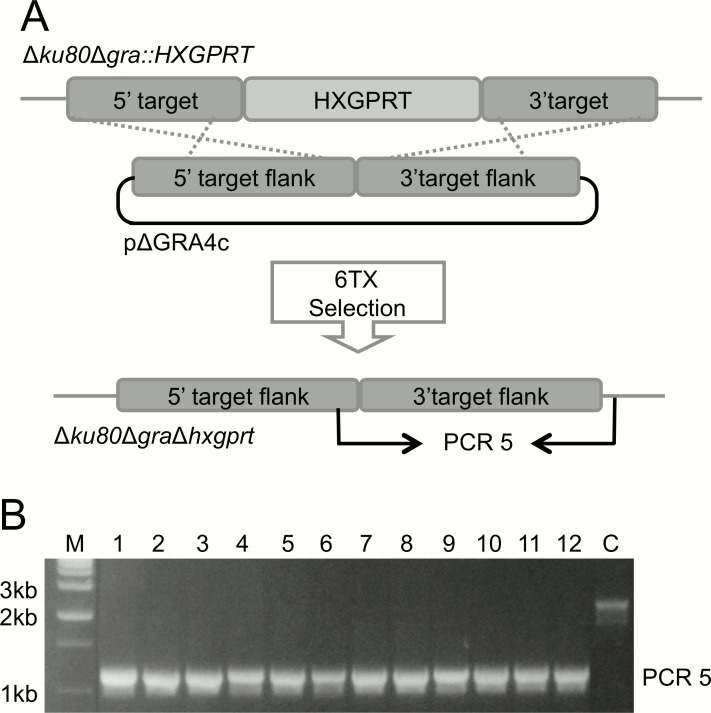
Strategy for removal of the HXGPRT selectable marker from a GRA gene locus.A) Removal of the HXGPRT selectable marker from RHΔku80Δgra::HXGPRT. This strategy is representative of each of the HXGPRT removal attempts. Following transfection with an HXGPRT-excised plasmid, clones lacking HXGPRT but containing the 5’ and 3’ flanking regions of the original GRA locus were generated by double-crossover homologous recombination, using 6TX selection. B) Validation of the HXGPRT removal from the gra4 gene locus. The parental strain exhibits a PCR5 amplicon of ~ 2,300 bp, corresponding to a DNA fragment that includes the HXGPRT coding sequence. Clones 1–12 exhibit a PCR5 amplicon of ~ 1,100 bp, which corresponds to the removal of HXGPRT. M: DNA size ladder; C: control parental strain.